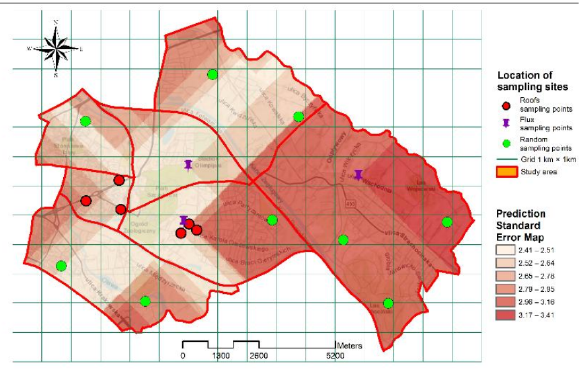
Figure 17. A new sample locations pattern optimized with the ordinary kriging interpolation model within the study